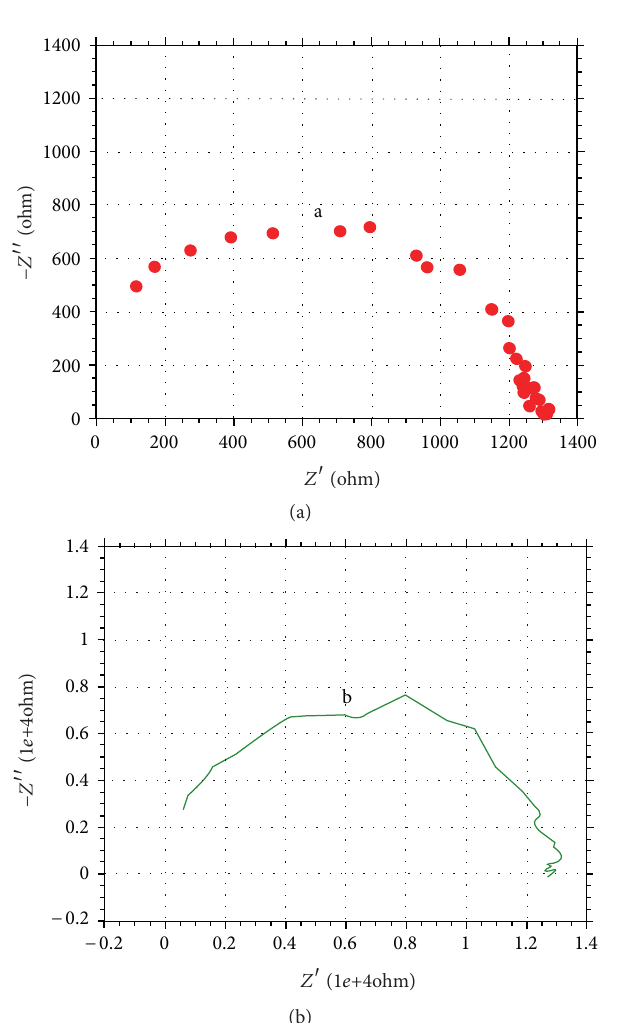
F 2: AC impedance spectra of carbon steel immersed in test solution (Nyquist plot) (pH=8). (a) Well water (blank). (b) Well water + DL-phenylalanine (150ppm) + Zn